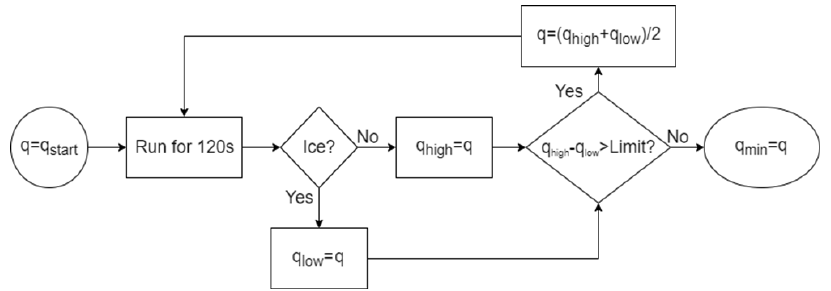
Figure 6. Flowchart of the minimum required anti-icing heat load procedure. Table 1. Anti-icing test matrix.